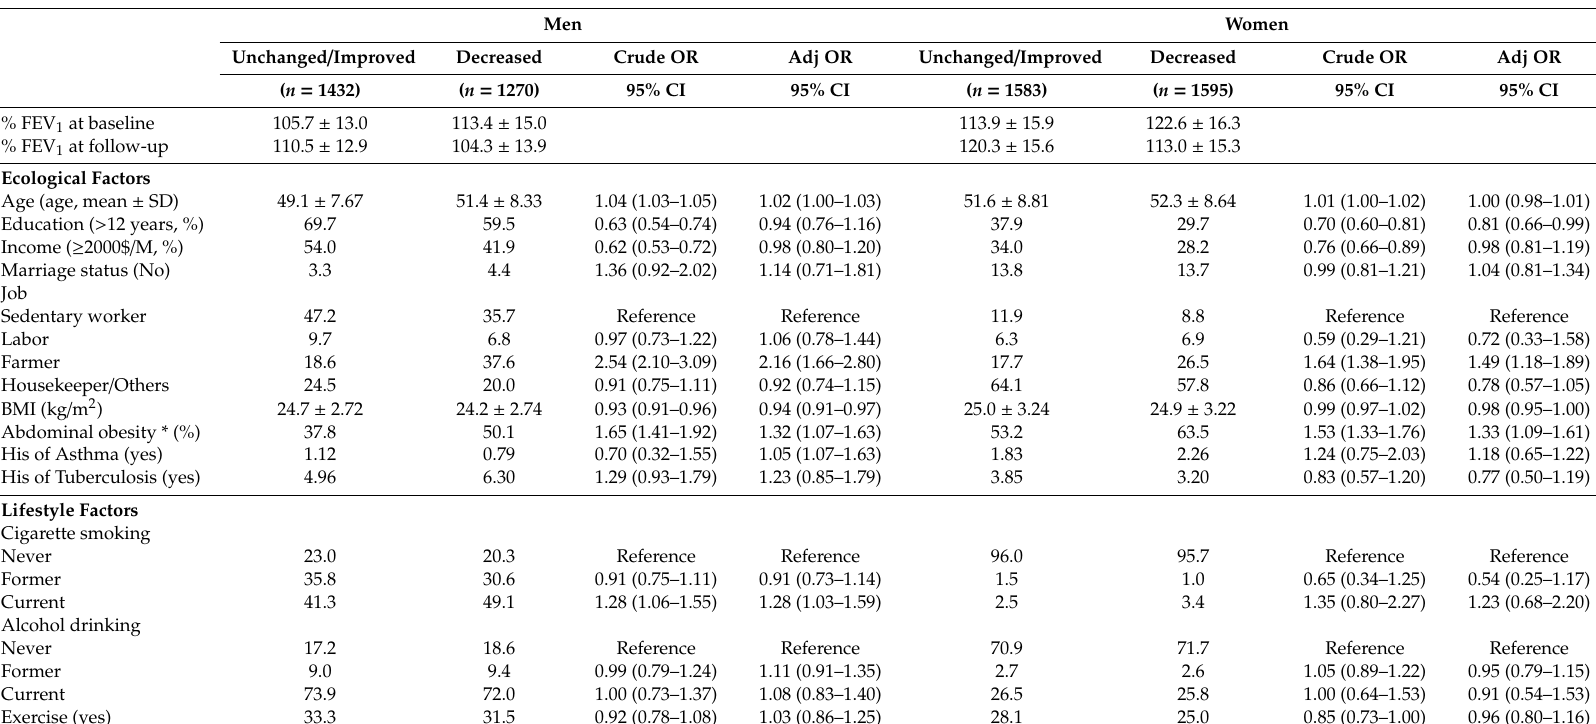
Table 1. The distribution of di ff erence of %FEV 1 (lung function) and the association with general and lifestyle factors according to gender. Men